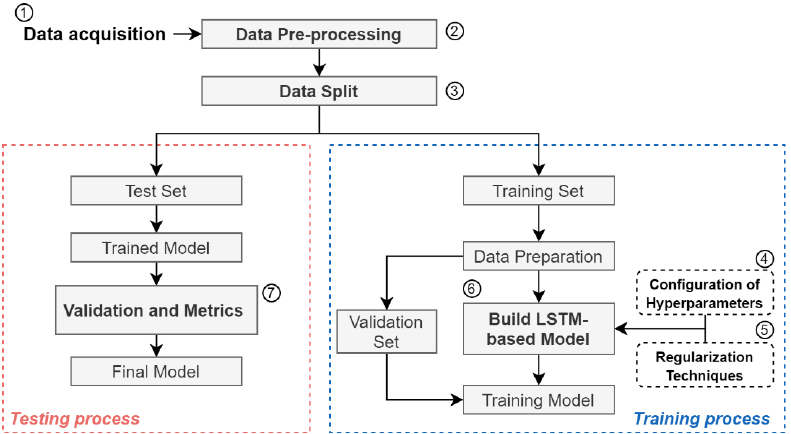
Figure 3. Flow diagram of the model development.